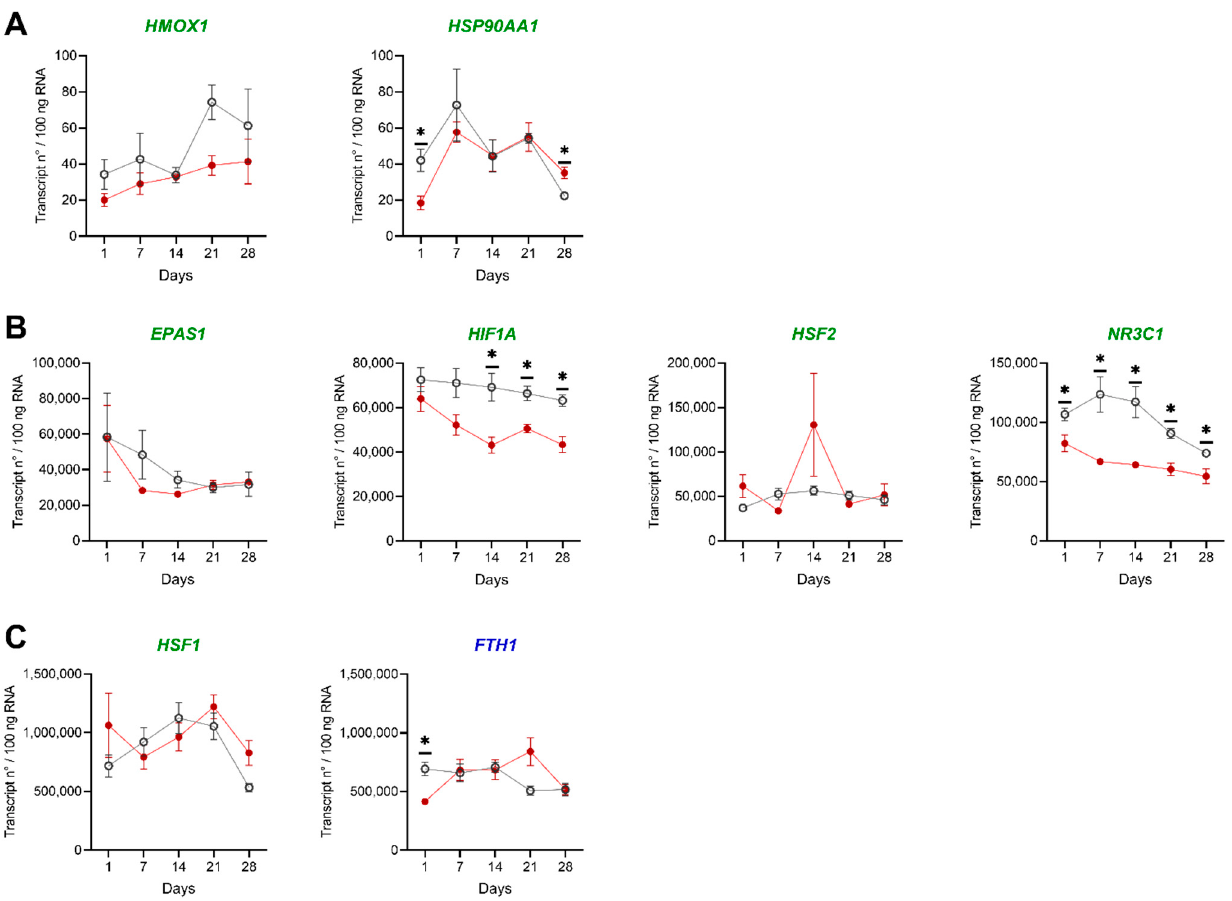
Figure 3. Stress and immune marker expression in HK of pikeperch exposed to low oxygen saturation. Gene expression of candidate genes in collected head kidney (HK) samples of pikeperch. Normoxic (grey/empty circles) and low DO (red/filled circles) groups after one, seven, fourteen, twenty-one and twenty-eight days of the experiment. Genes involved in stress (green) or immune response (blue) were either lowly ( A ), moderately ( B ) or highly ( C ) expressed. Data points represent the mean of five individual samples (+SEM), calculated per 100 ng of total RNA. Statistical significance was determined between groups for each day using the multiple t-test (Holm–Šídák corrected), with alpha = 0.05; * < 0.05 .